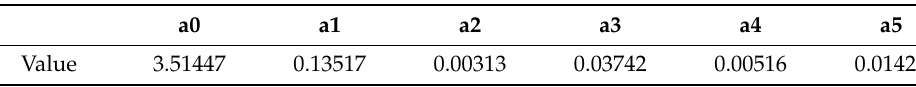
Figure 1. Performance curve of heat source equipment. Table 3. Model Table 3. Model parameters.